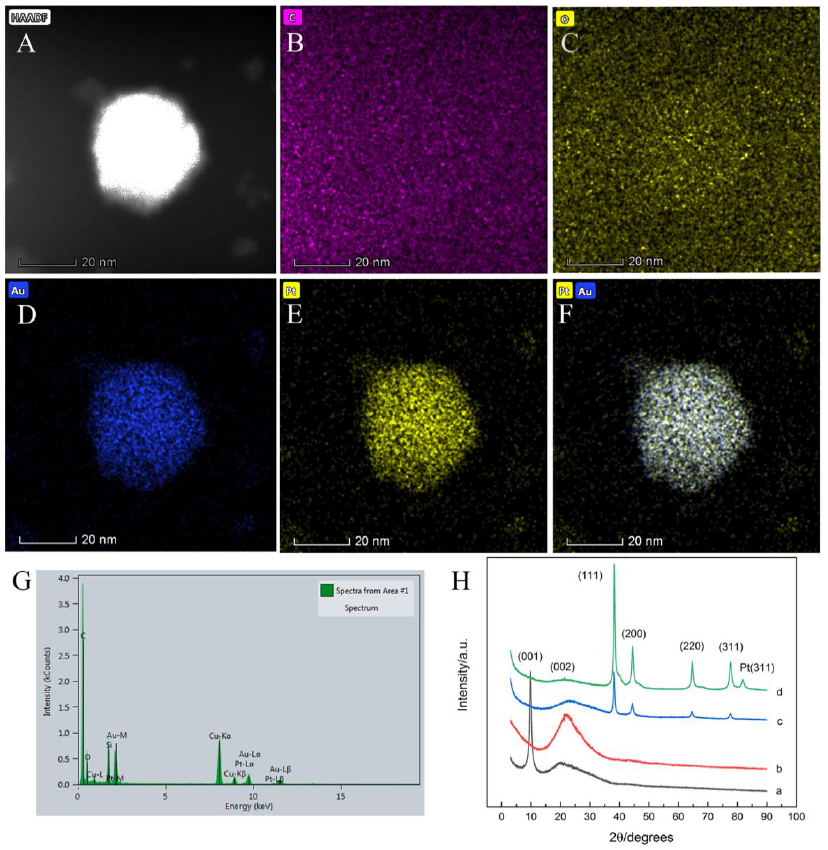
Figure 2. Images of ( A ) Au@Pt-PEI-RGO and elements of ( B ) C, ( C ) O, ( D ) Au, ( E ) Pt, and ( F ) Au@Pt; ( G ) energy-dispersive X-ray spectroscopy (EDX) spectrum of Au@Pt-PEI-RGO; ( H ) X-ray diffraction (XRD) patterns of (curve a) GO, (curve b) PEI-RGO, (curve c) Au-PEI-RGO, and (curve d) Au@Pt-PEI-RGO.